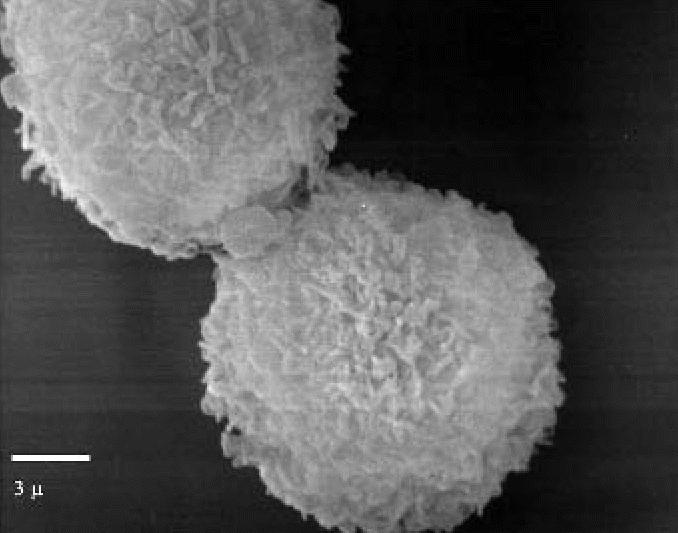
Scanning electron micrograph showing the surface pattern of small macrophages (exposed subject). Note the fine philopodial expansions. Bar = 3 μm.